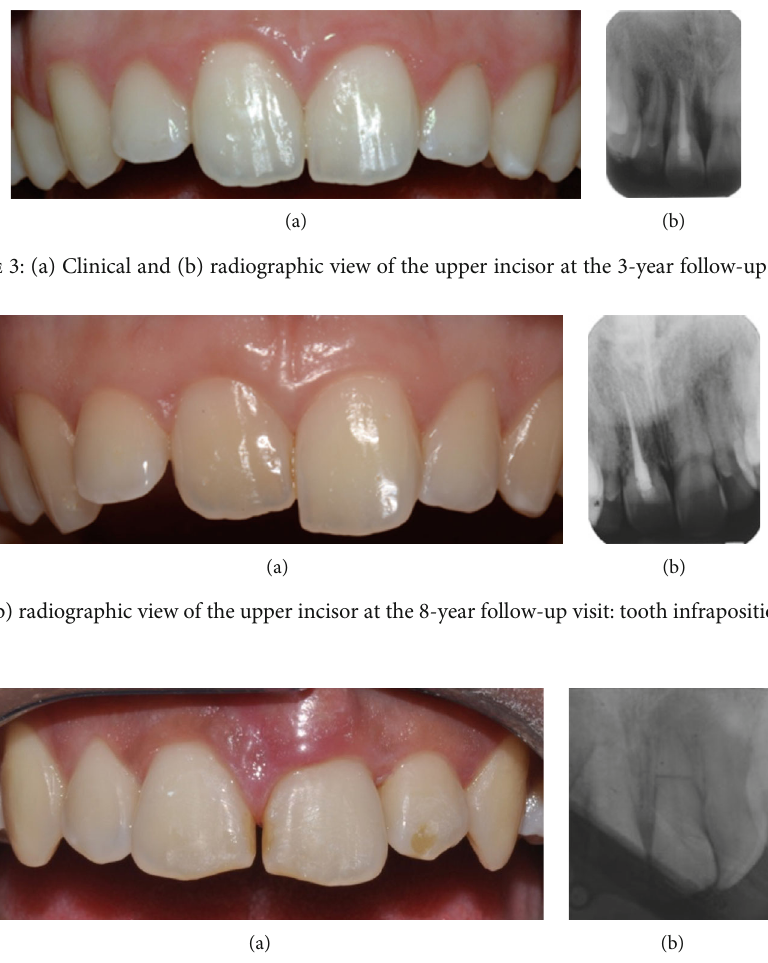
Figure 5: Posttraumatic (a) clinical and (b) radiographic view. Gingival tissues around the upper left central incisor are swollen and red, while a horizontal root fraction is detectable from the periapical